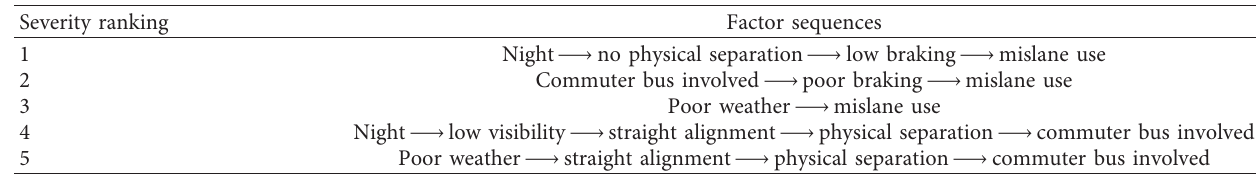
Table 10: Factor combination sequence result for the number of deaths.